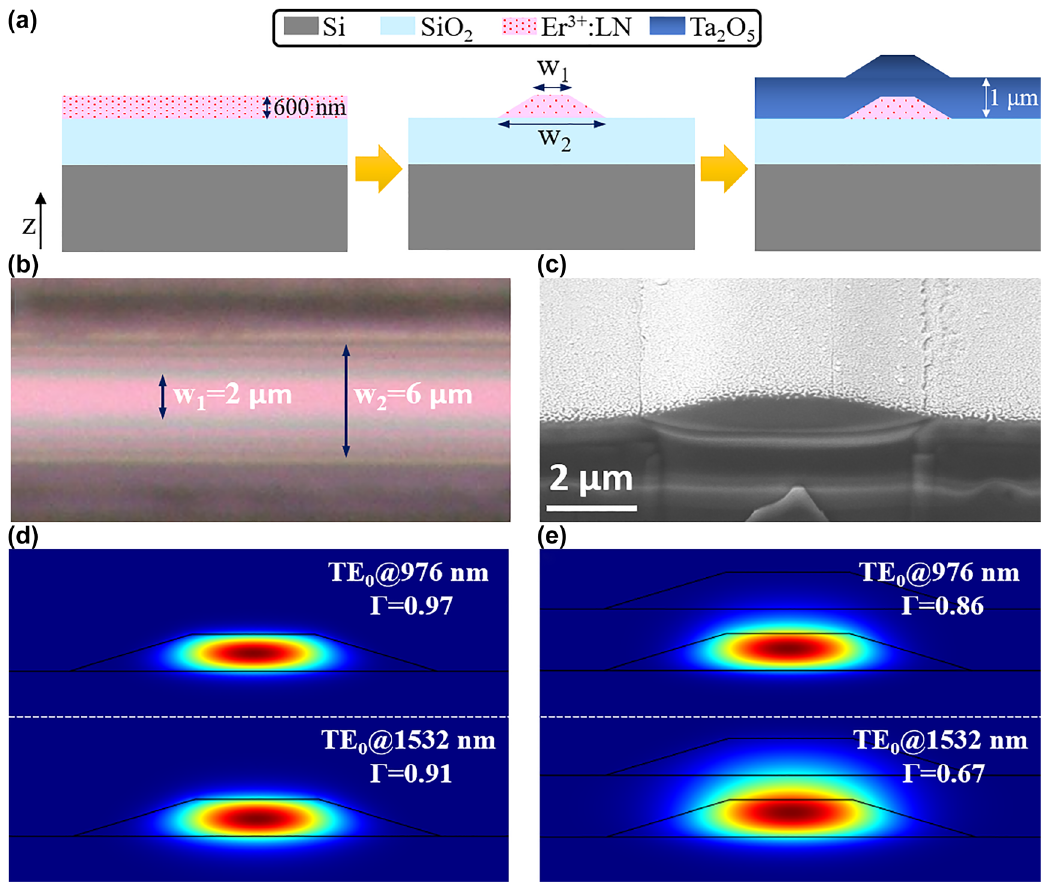
Figure 1: Er 3 + :LNOI waveguide fabrication and con fi guration. (a) Cross-sectional schematic of the Z-cut Er 3 + :LNOI wafer, the fabricated LNOI waveguide, and the Ta 2 O 5 -cladding on top of the LNOI waveguide. (b) Top view microscope image of the air-clad LNOI waveguide. (c) SEM image of the Ta 2 O 5 -clad LNOI waveguide cross section. (d and e) The simulated fundamental TE modes for the air-clad and Ta 2 O 5 -clad waveguides at the pump and signal wavelengths. The power con fi nement factor Г is labelled in each panel.